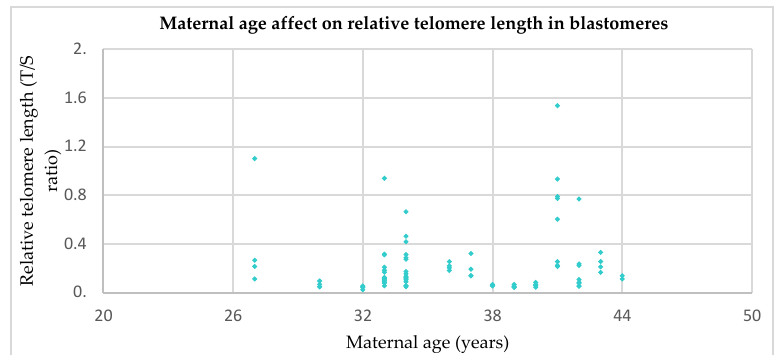
Figure 4. Telomere length in blastomeres from cleavage stage embryos in relation to maternal age ( n = 86 blastomeres from n = 22 couples). Results show no correlation ( p = 0.14).